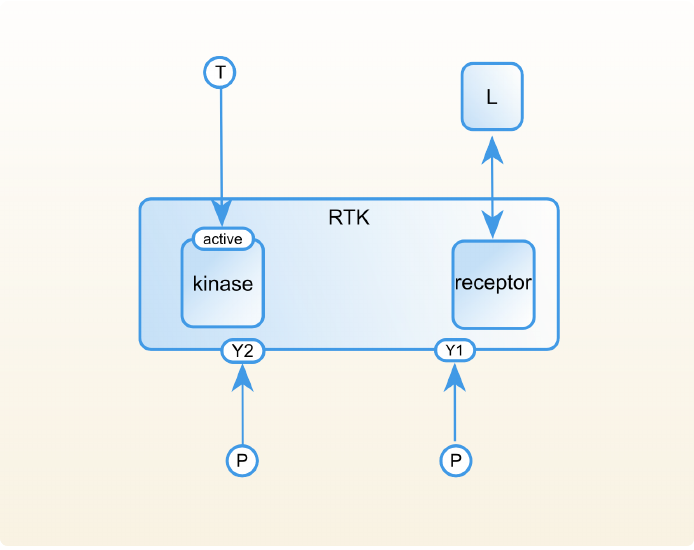
Figure A.3: Receptor tyrosine kinase activation: receptor-ligand